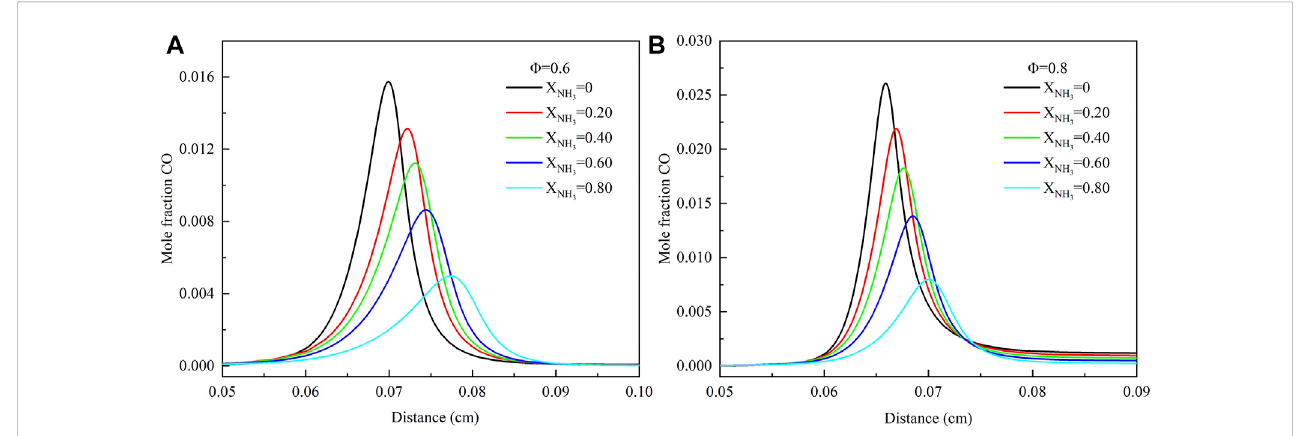
FIGURE 13 Mole fraction of CO with different ammonia content: (A) Φ = .6; (B) Φ = .8. (T = 723 K, p = 16.5 atm).